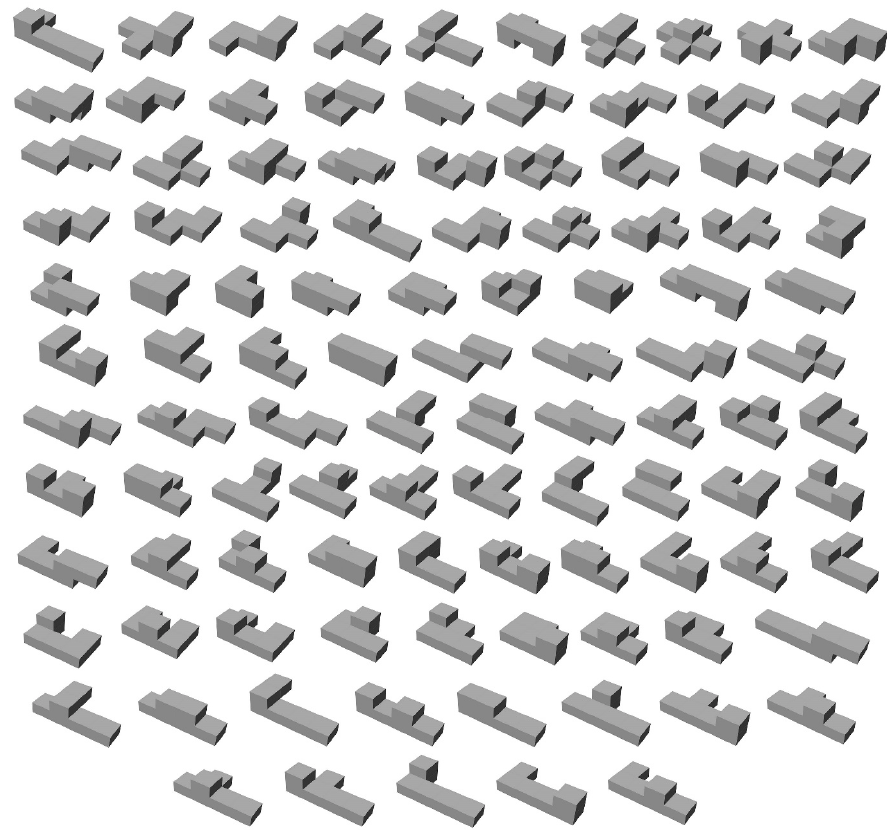
Figure 11. The generated 2-level batches (105 building shapes).